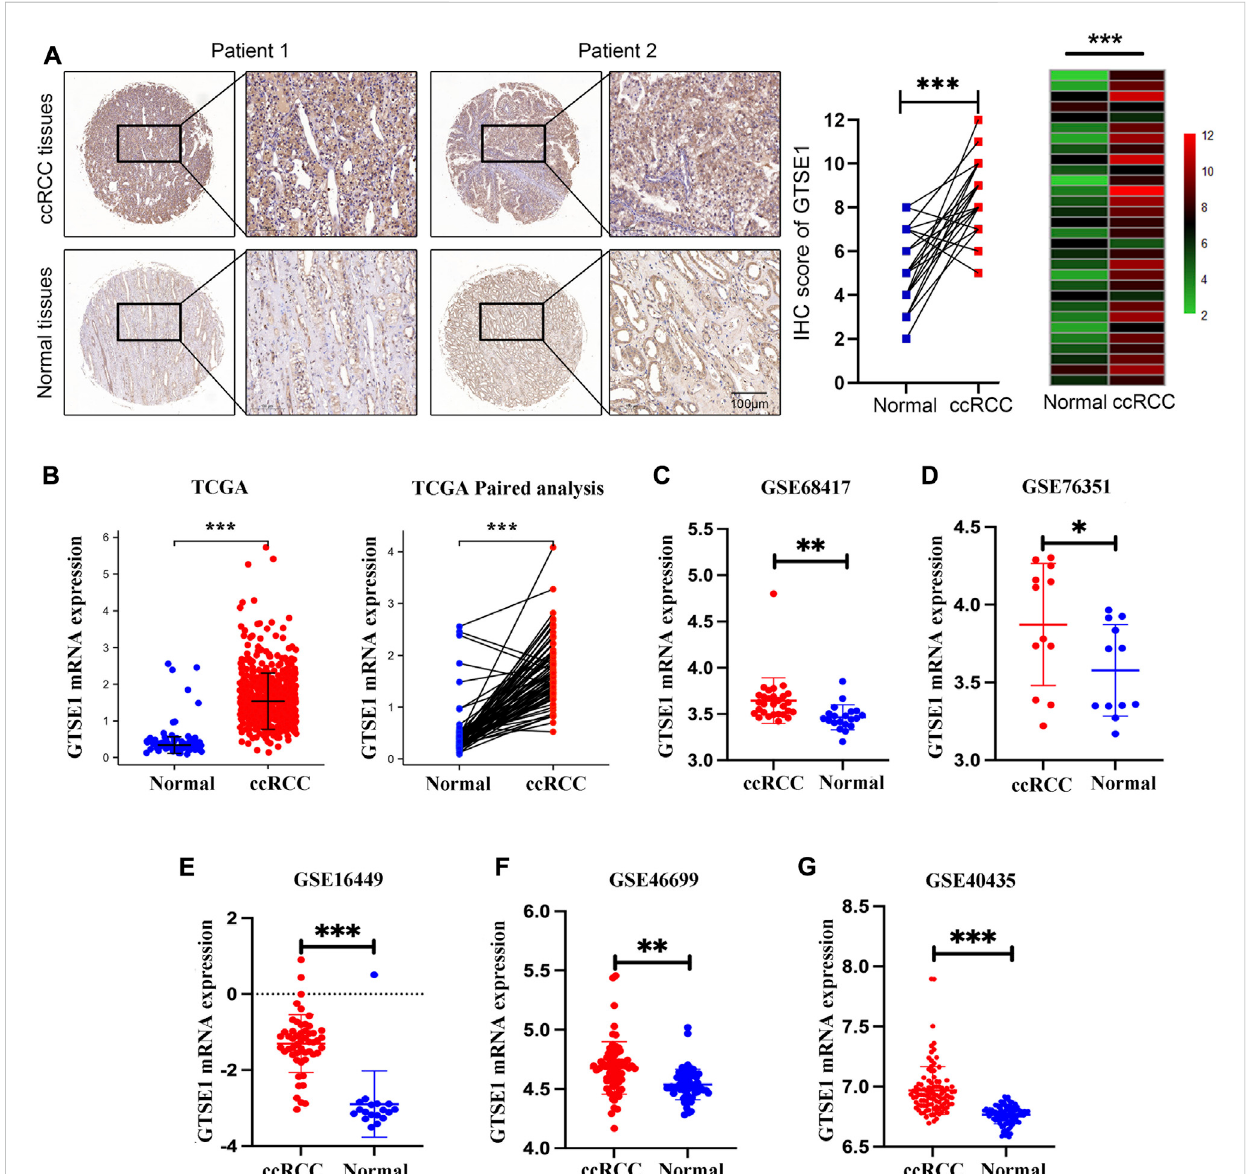
FIGURE 1 High expression of GTSE1 in ccRCC. (A) Representative images of IHC staining of GTSE1 in ccRCC tissues and matched normal tissues (n = 30). The IHC score of each tissue in ccRCC tissues and matched normal tissue were analyzed and exhibited in scatter diagrams and heatmaps. (B) GTSE1 mRNA levelinccRCCsampleswasshowninTCGApairedandunpairedanalysis. (C – G) GTSE1mRNAlevelsinccRCCtissuesandnormaltissuesinGSE68417 (C) , GSE76351 (D) , GSE16449 (E) , GSE46699 (F) and GSE40435 (G) . * p < 0.05, ** p < 0.01, *** p <